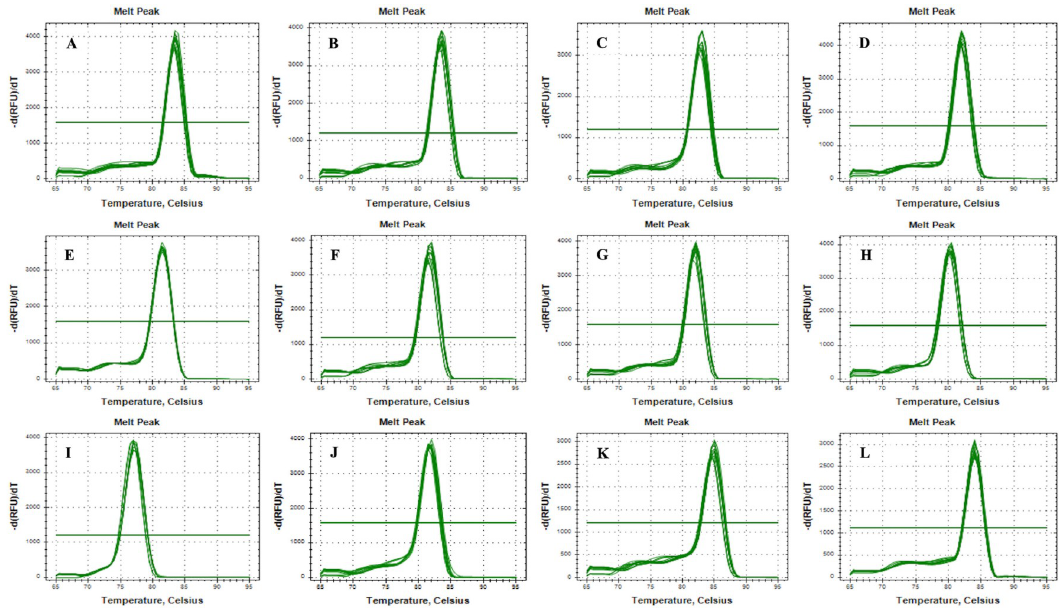
Fig 1. Melting curves for candidate reference genes and target gene. A: Actin1 , B: AK , C: EF1- α , D: GAPDH , E: Mdh , F: Pur , G: RpS6 , H: TAF , I: α -Tub , J: Ubp , K: SDHA , L: Mh-Hsp 90 .